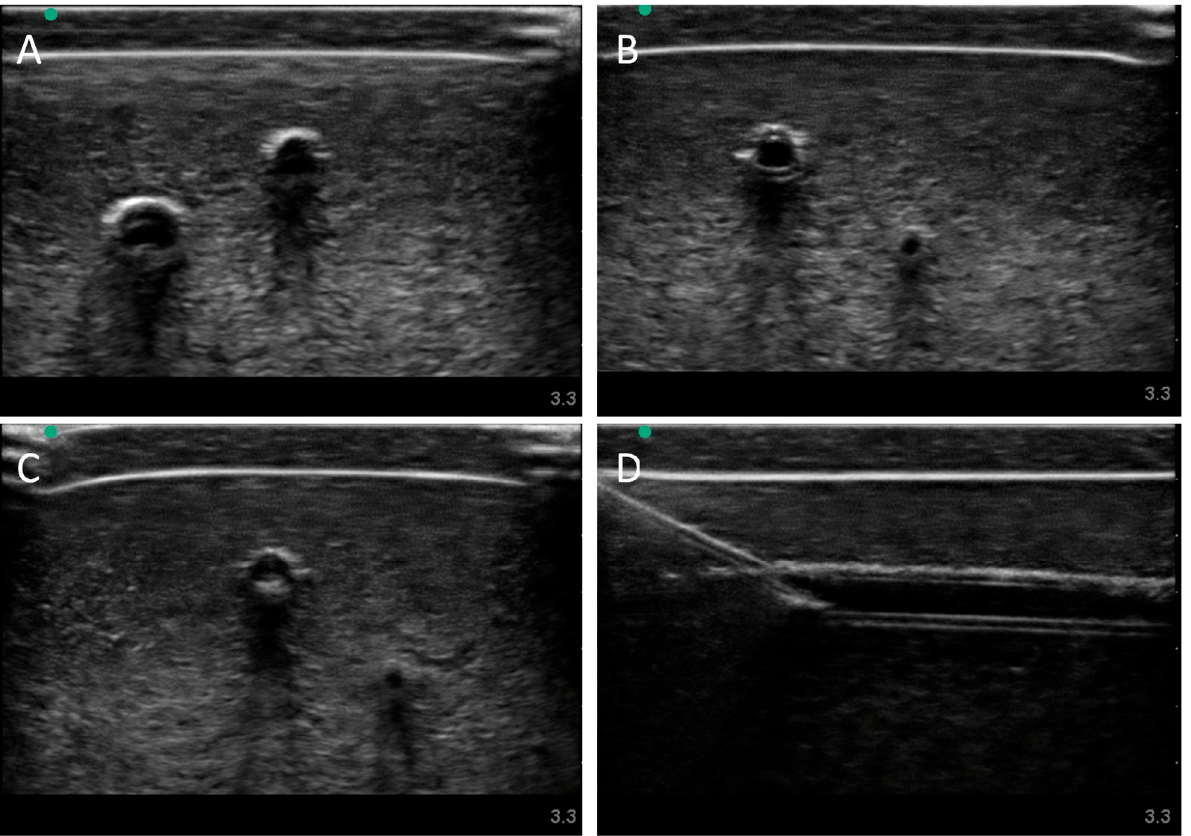
Figure 4. Porcine gelatin phantom ultrasound results. ( A ) Normovolemic OOP view of artery and